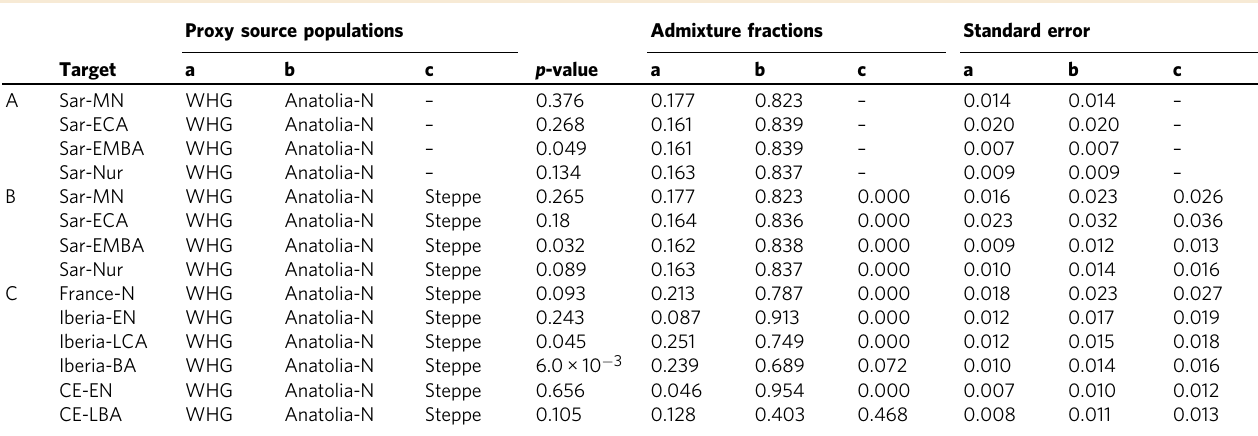
Table 1 Results from fi tting models of admixture with qpAdm for Middle Neolithic to Nuragic period. Proxy source